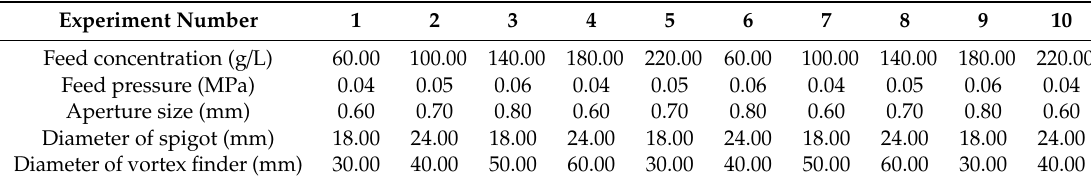
Table 2. Experimental